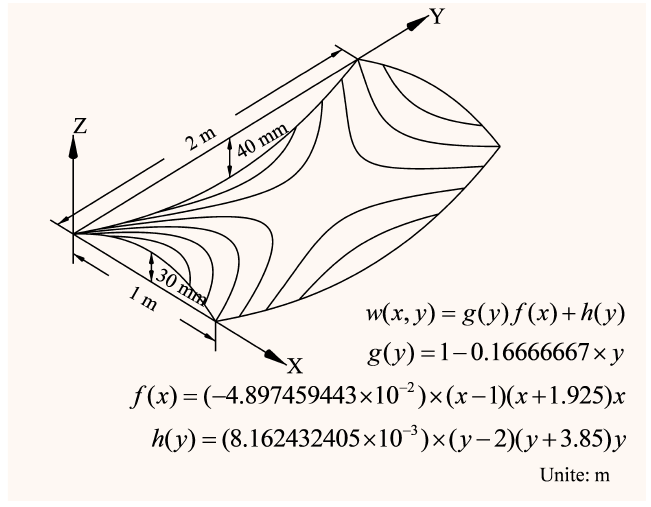
Figure 12. Shape of a curved plate.